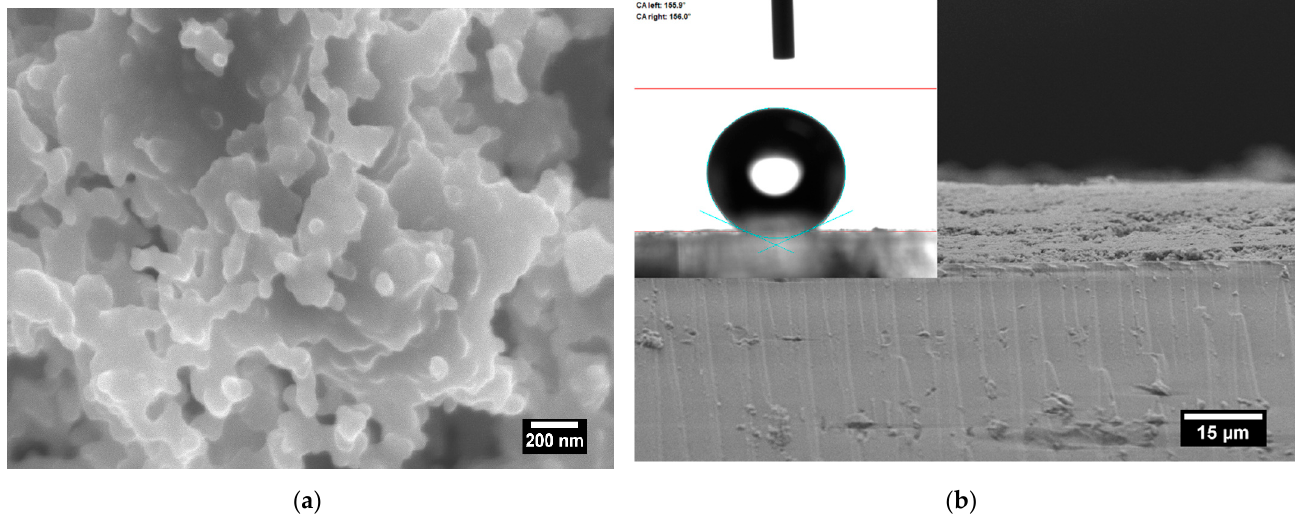
Figure 1. Top-view and cross-sectional scanning electron micrographs indicating ( a ) the morphology and structure, and ( b ) the thickness of the soot coatings, where the substrate-soot interface is easily distinguishable. The inset in Figure 1b reveals the static contact angle of a 10 μ L water droplet resting on the soot.